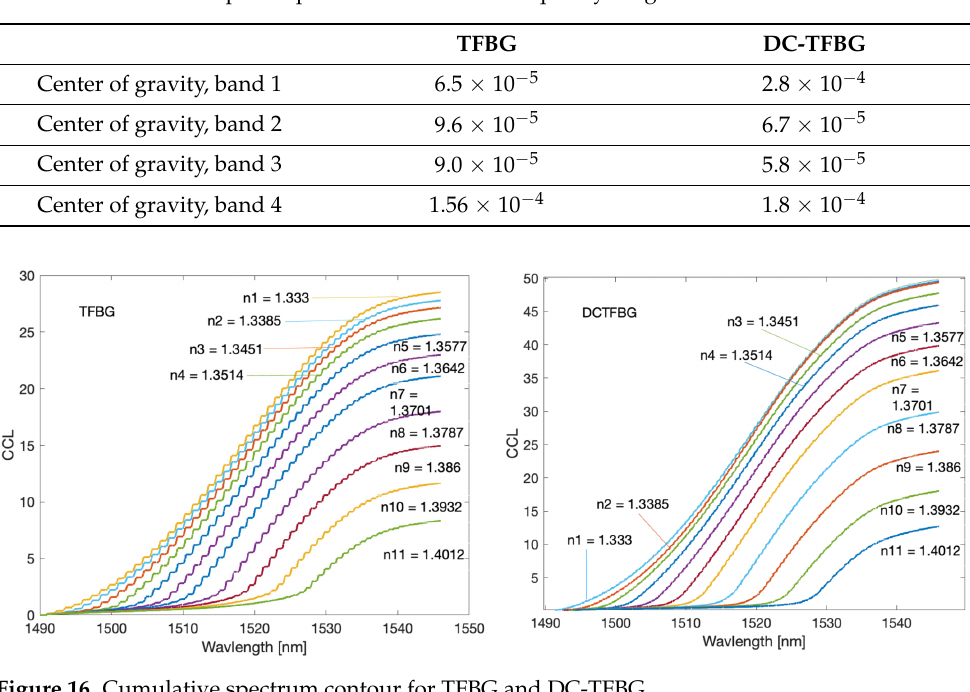
Table 3. Comparison of the resolution for the Hilbert envelope centre of gravity method for the TFBG and the DC-TFBG for optical spectra for individual frequency ranges.